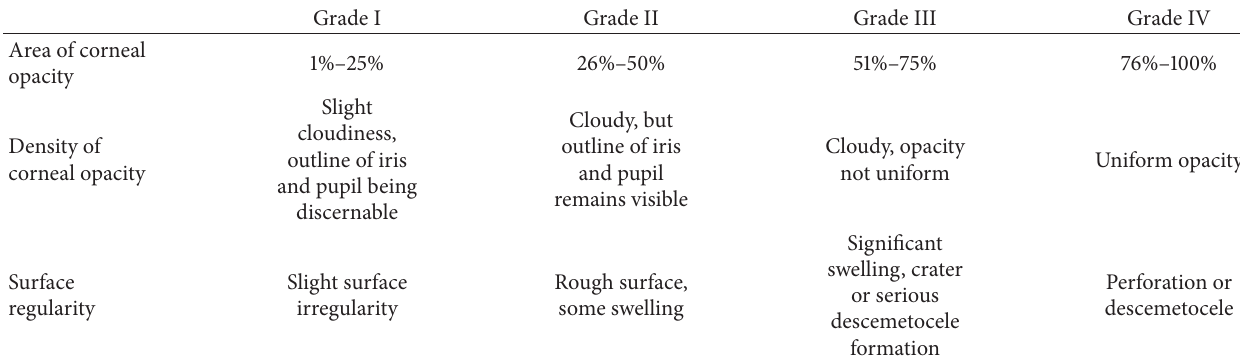
Table 1: Quantitative scoring system for rabbit Fusarium keratitis.